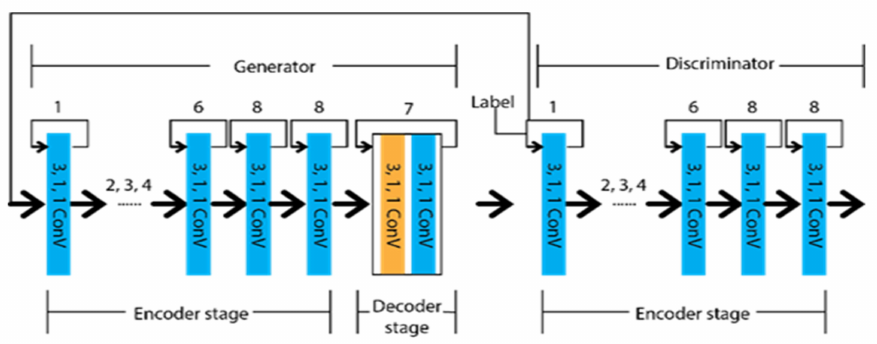
Figure 7. Schematic diagram of